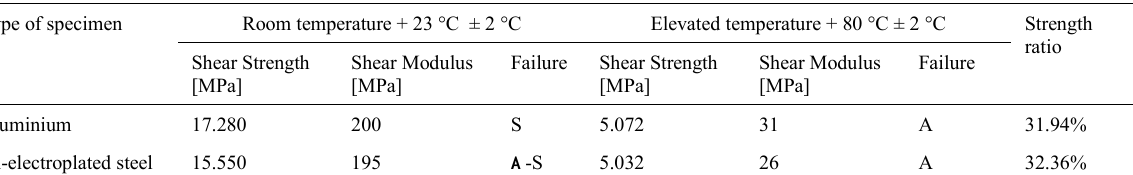
Table 3: Specimens with 3 mm adhesive layer thickness.